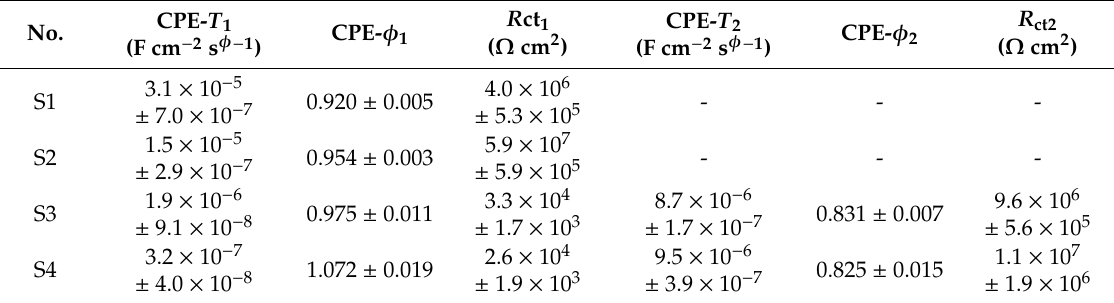
Table 2. Parameters values obtained using the equivalent circuit models shown in Figure 11 to approximate the experimental electrochemical impedance spectroscopy (EIS) data for the NiTi alloy before and after surface modification in Ringer's solution at 37 °C (see Figure 12a,b). No.